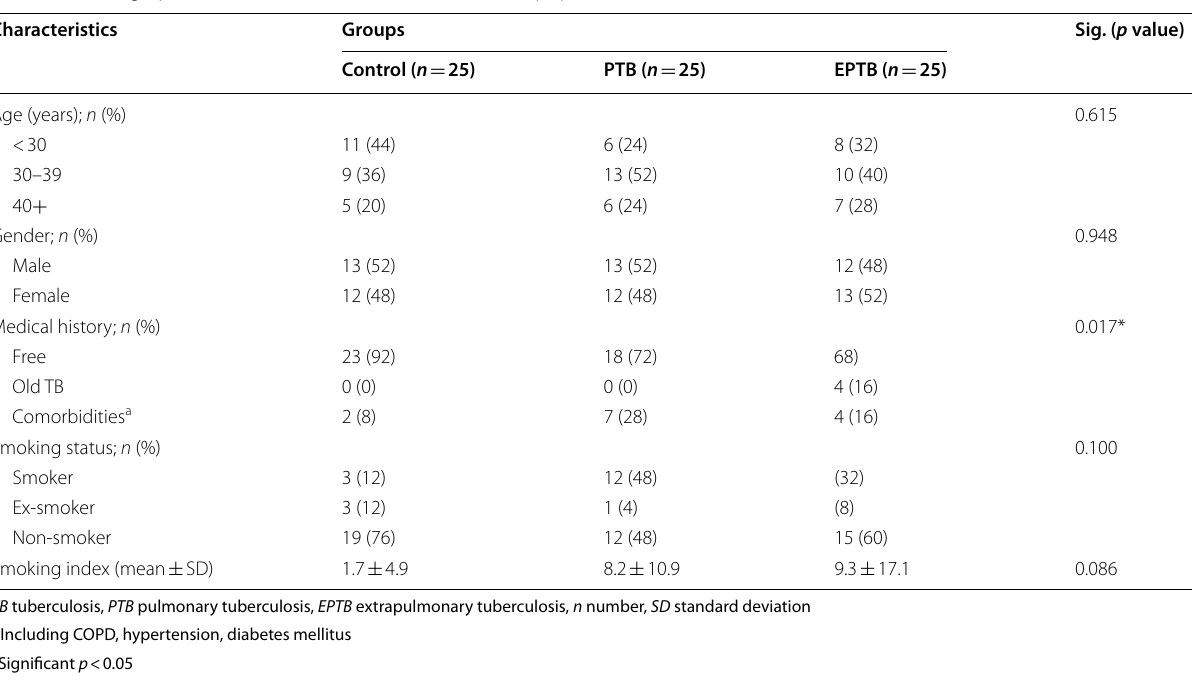
Table 2 Demographic and clinical characteristics of studied population